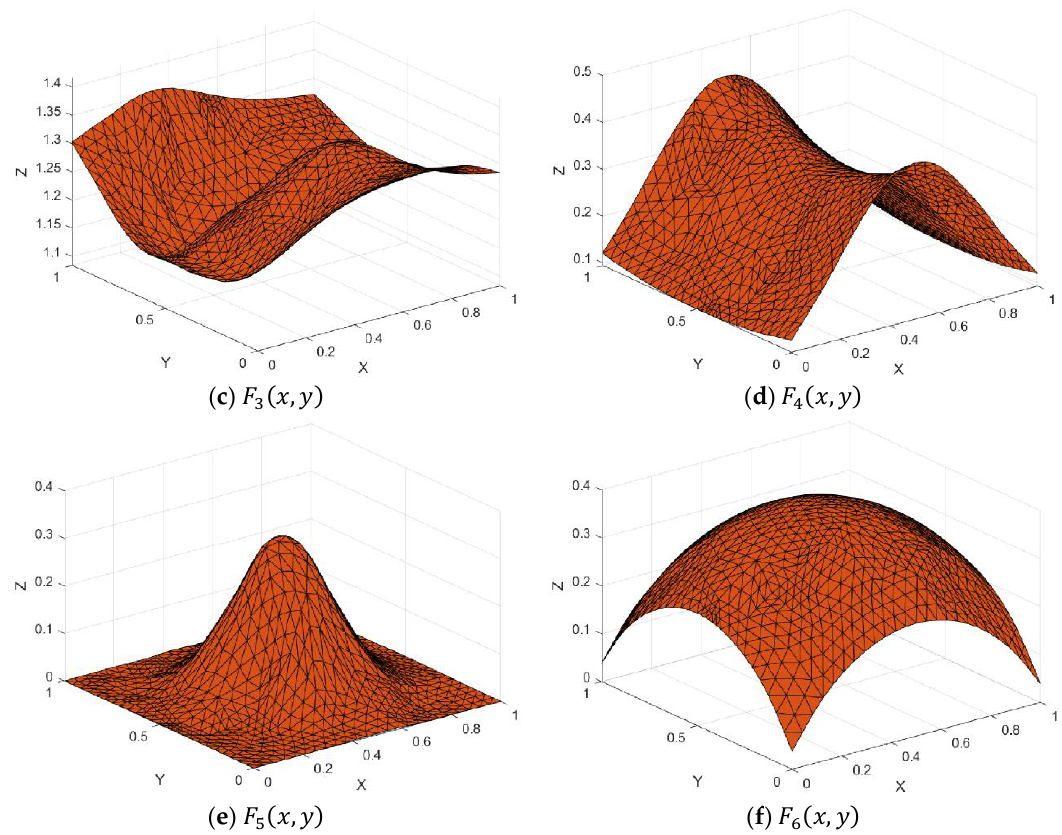
Figure 23. Surface interpolation using Foley and Opitz method and Choice 2 for 100 datasets.